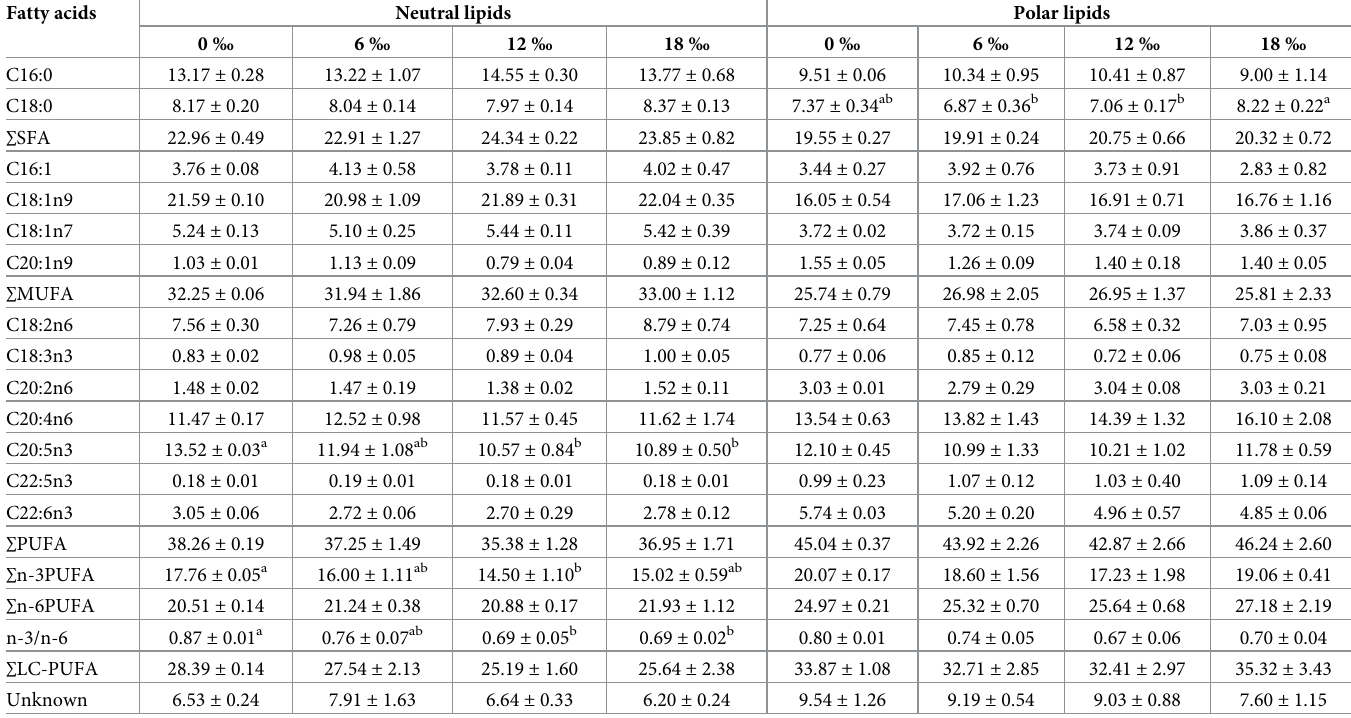
Table 2. The principal fatty acid profiles (% total fatty acids) of the neutral lipids and polar lipids in the gonads of adult male E . sinensis . Fatty acids Neutral lipids Polar lipids